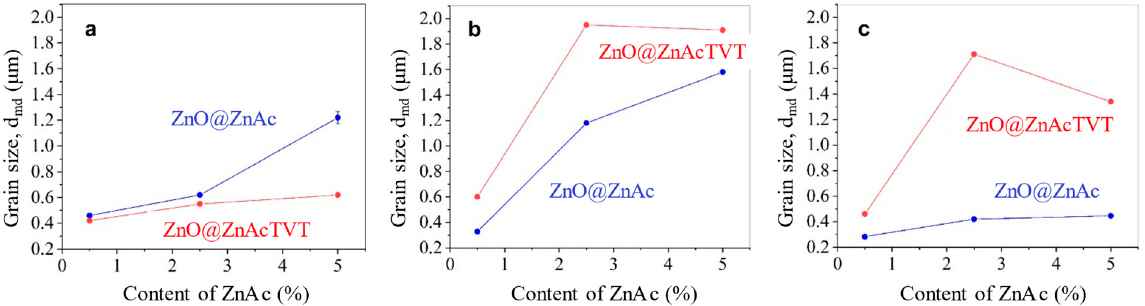
Figure 10. Median of grain size distribution of ZnO ceramics vs. ZnAc concentration for different types of sealing during CSP: single copper sealing 1C ( a ); double copper sealing, 2C ( b ); double PTFE sealing, 2P ( c ). Initial ZnO powder activation: ZnO@ZnAc-impregnation; ZnO@ZnAcTVT-impregnation followed by TVT.